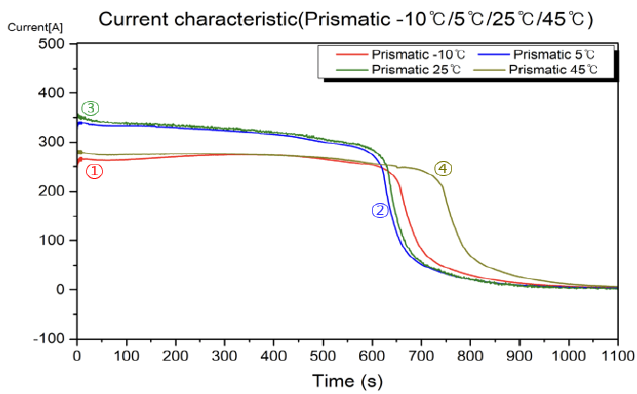
Figure 11. Current status of prismatic cell during testing according to preprocessing temperature.